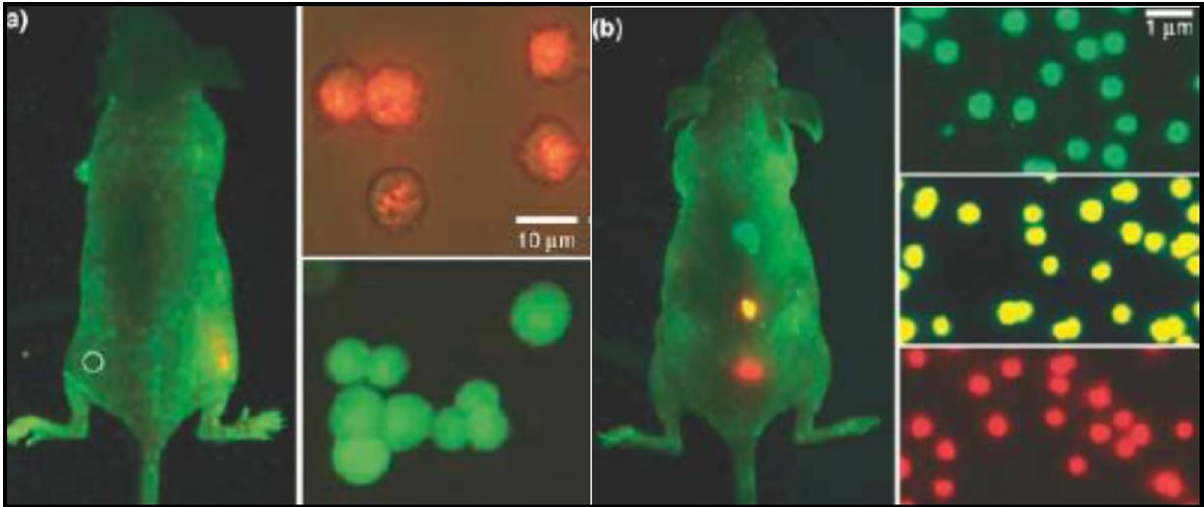
Figure 11: ( a ) Cancer cells marked with standard methods ( white circle ) compared with quantum dot tagged cancer cells ( bright orange ) and ( b ) di ff erent types of QDs injected beneath the skin of a mouse [ 43 ] .